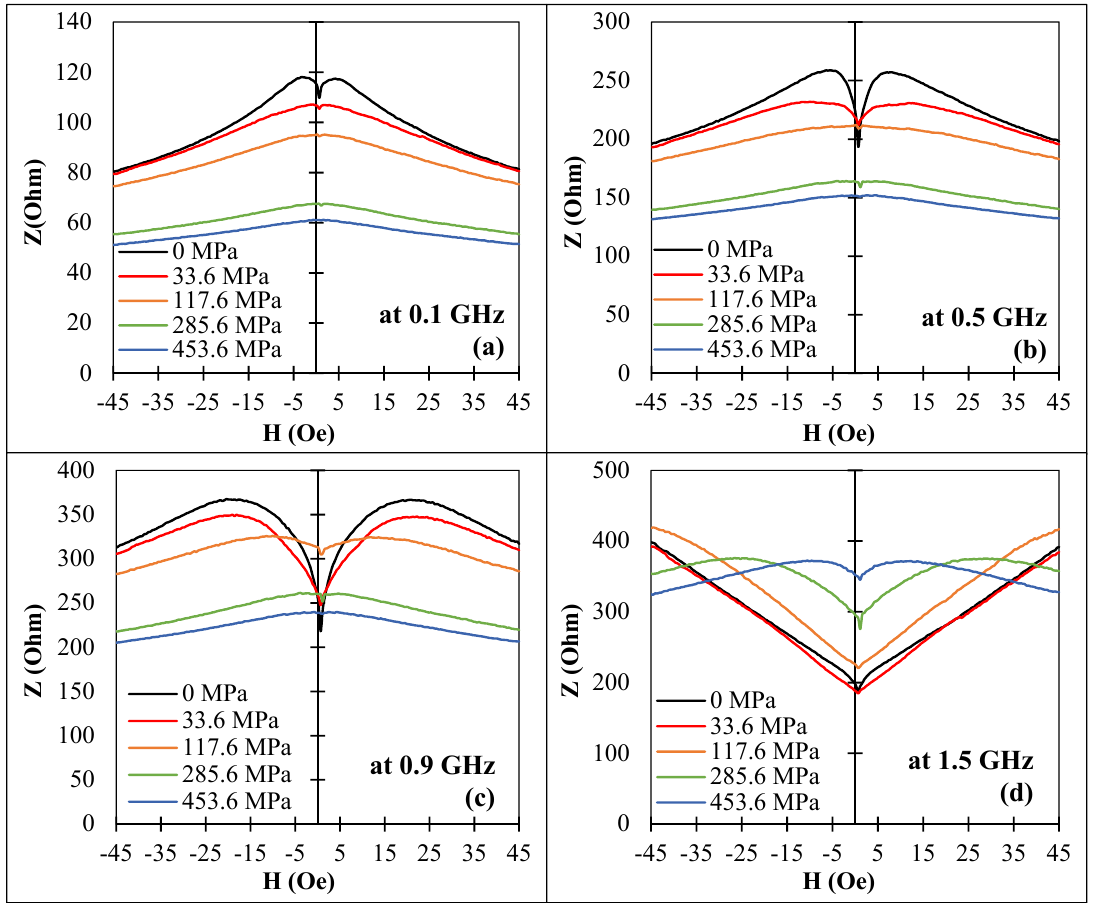
Figure 14. Effect of a tensile stress on the MI vs. magnetic field behavior for amorphous Co 71 Fe 5 B 11 Si 10 Cr 3 microwires (sample No3) in as-prepared state at frequencies: ( a ) 0.1 GHz, ( b ) 0.5 GHz, ( c ) 0.9 GHz, and ( d ) 1.5 GHz. Z corresponds to the impedance amplitude.